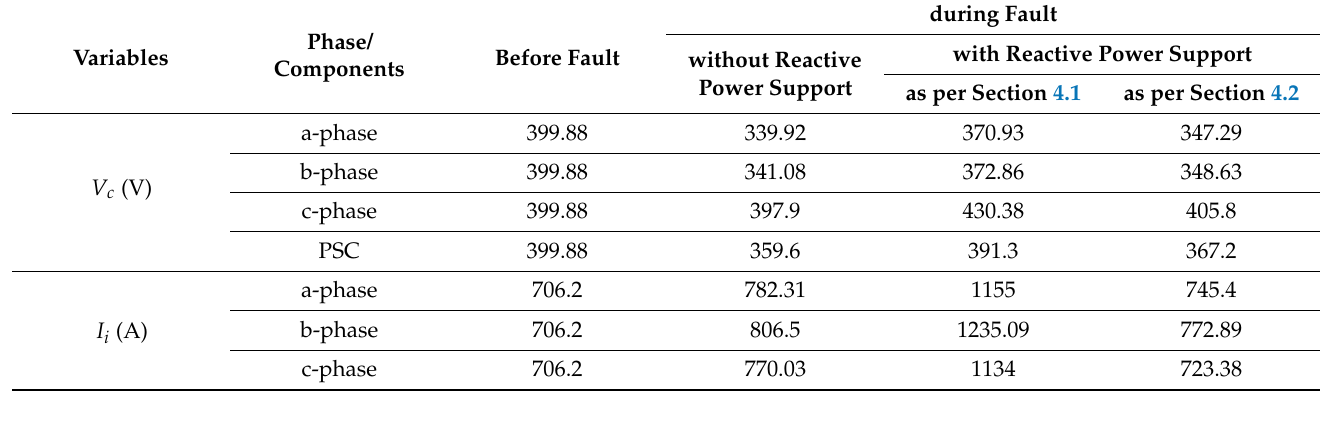
Figure 8 . PCC voltage enhancement during two-phase to ground fault: (i) without reactive power support; (ii) with reactive power support as described in Section 4.1; (iii) with reactive power support as defined in Section 4.2. Table 1. Performance evaluation under two-phase to ground fault.